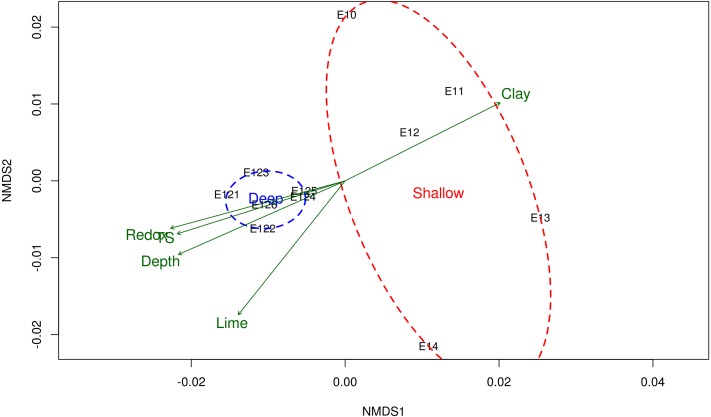
Non-metric multidimensional scaling (NMDS) of the bacterial community structure and the environmental variables.Ordination of samples based on the weighted UniFrac distance from the community structure and their relationship with the physicochemical variables. Shallow sites included samples collected from 20 to 600 m, and deep sites from 2,800 to 3,700 m depth. Physicochemical variables related to the bacterial community structure are shown in green arrows. TS total sulfur concentration. NMDS stress value = 0.0684.